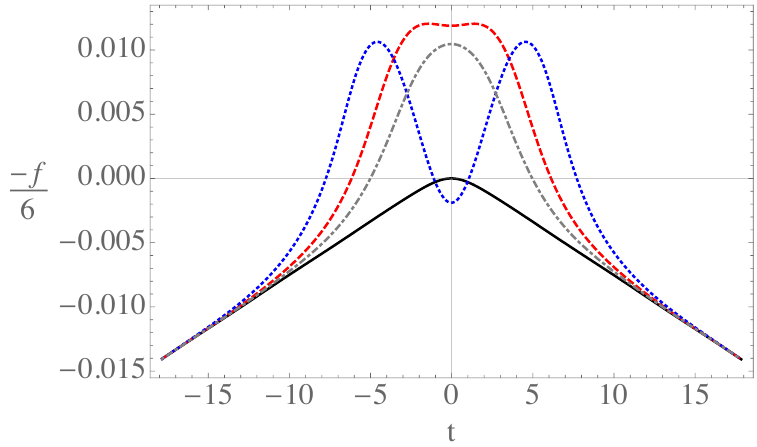
Figure 2 . This (cid:12)gure shows the time-dependence of leading semiclassical saddles contributing to 1 log , with di(cid:11)erent (cid:11) I = 1 ; 3 = 5 ; i= 2 ; 5 i= 4 (black, solid; gray, dot-dashed; red, dashed; and blue, c V dotted, respectively) and (cid:12)xed (cid:11) L = 0 : 99 and T H = 2 (cid:25) . The solid black line corresopnds to (cid:11) I = 1, which is the vacuum Virasoro block. For ease of comparison we have made an overall constant shift in each f to emphasize that the late-time exponential decay is completely independent of the intermediate operator dimension. See (cid:12)gure 13 for more